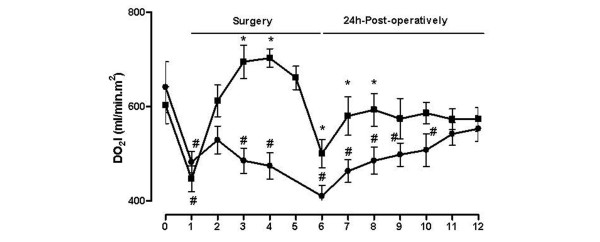
Oxygen delivery index during surgery and postoperatively. Oxygen delivery index (DO2I) during surgery and postoperatively for the volume group (●) and the dobutamine group (■). *P < 0.05 versus volume group, #P < 0.05 versus baseline. Results presented as the mean and standard error or the mean. 0, preoperative; 1, 30 min intraoperatively; 2, 2 hours intraoperatively; 3, 4 hours intraoperatively; 4, 6 hours intraoperatively; 5, 8 hours intraoperatively; 6, 0 hours postoperatively; 7, 4 hours postoperatively; 8, 8 hours postoperatively; 10, 12 hours postoperatively; 11, 16 hours postoperatively; 12, 24 hours postoperatively.